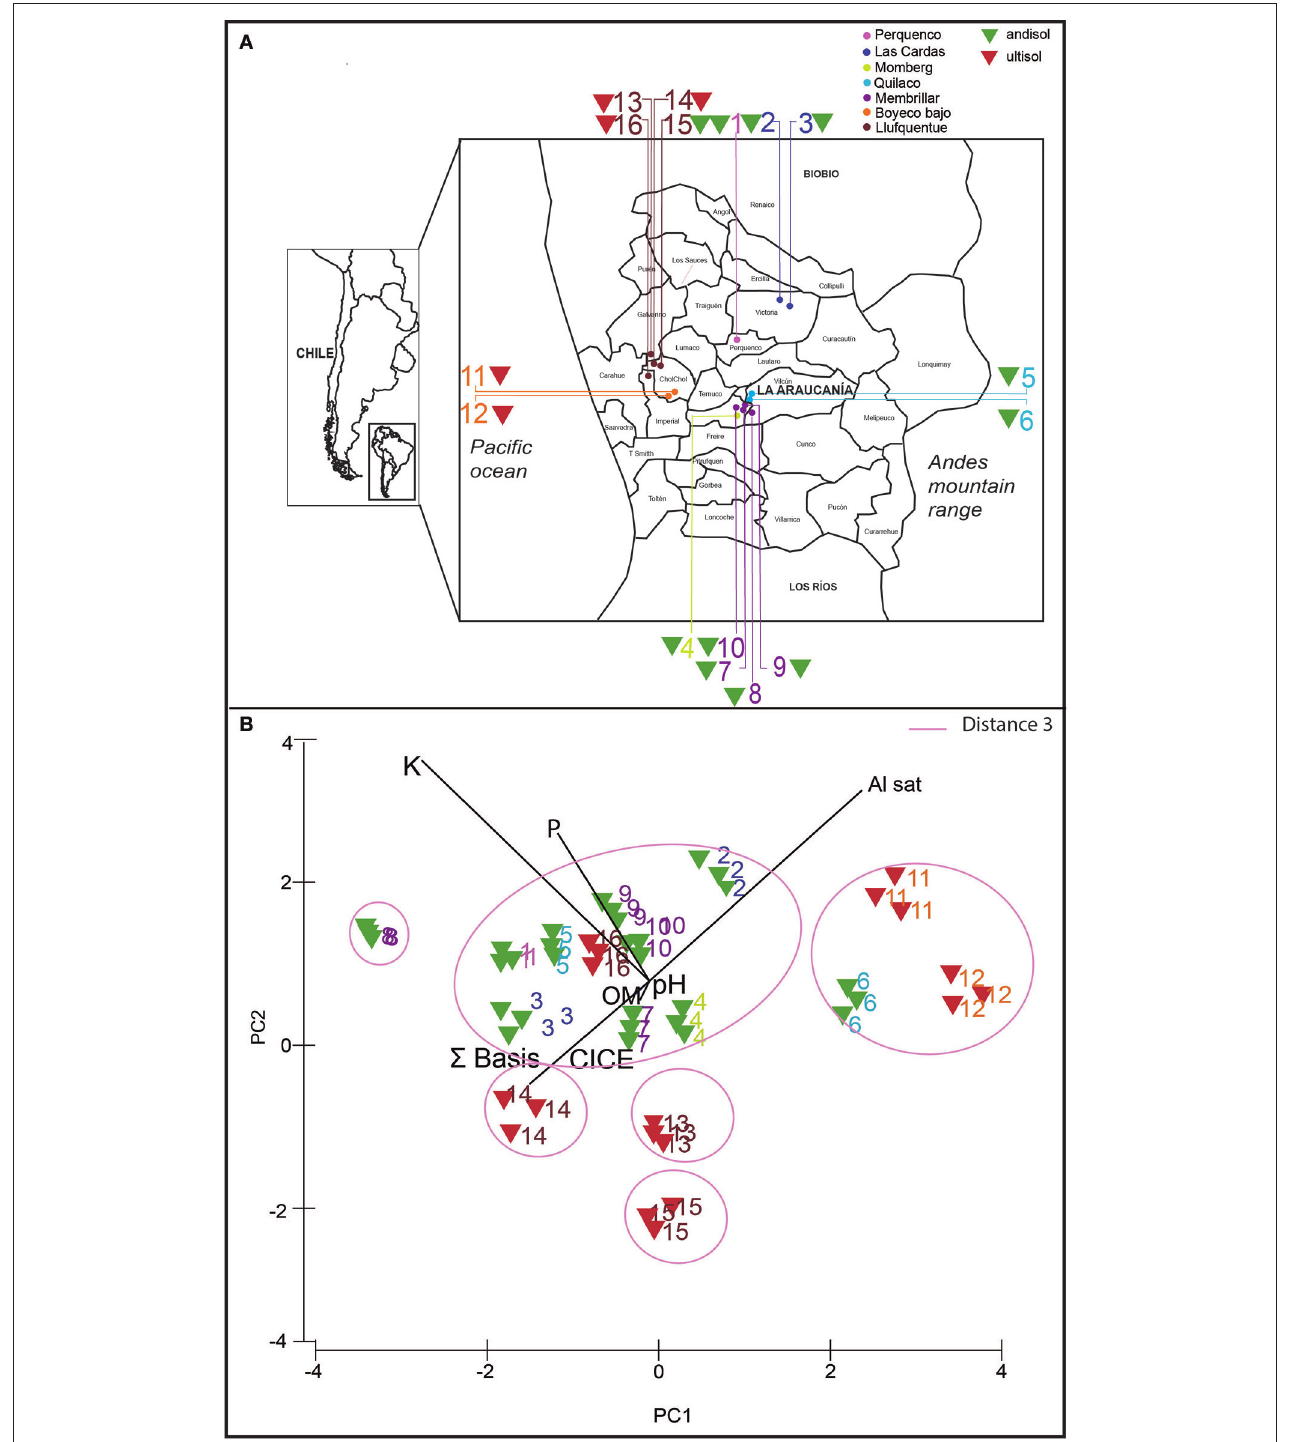
FIGURE 1 | Sampling locations (A) and principal component analysis (PCA) analysis (B) based on chemical properties of 16 rhizosphere soils used in this study. Triangle colors indicate type of soil: andisol (green) and ultisol (red).